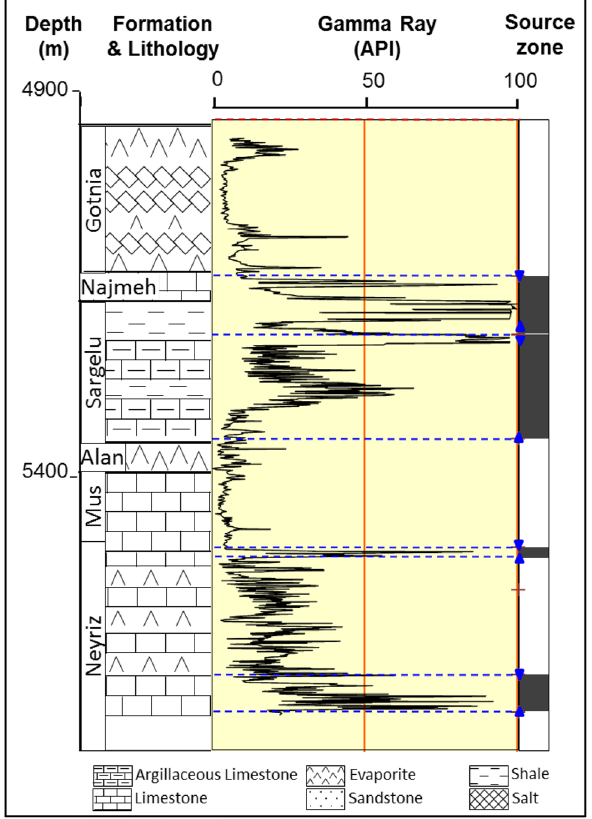
Fig. 3 Depth vs. gamma-sonic log and organic-rich zones in Dar- quain Well